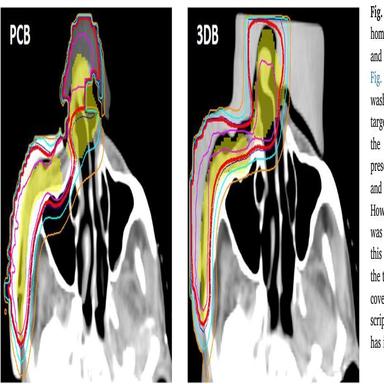
Representative images comparing homogeneity and conformity for PCB (left) and 3DB (right) for the bolus described in are shown. The area in yellow color wash is the high-risk radiation planning target volume. The thick red line represents the prescription isodose line (95% of the prescription dose). For this plan, both PCB and 3DB had a heterogeneity index of 1.3. However, the conformity index with 3DB was 0.96, and for PCB was 0.60. Therefore, this indicates that a significant portion of the ta